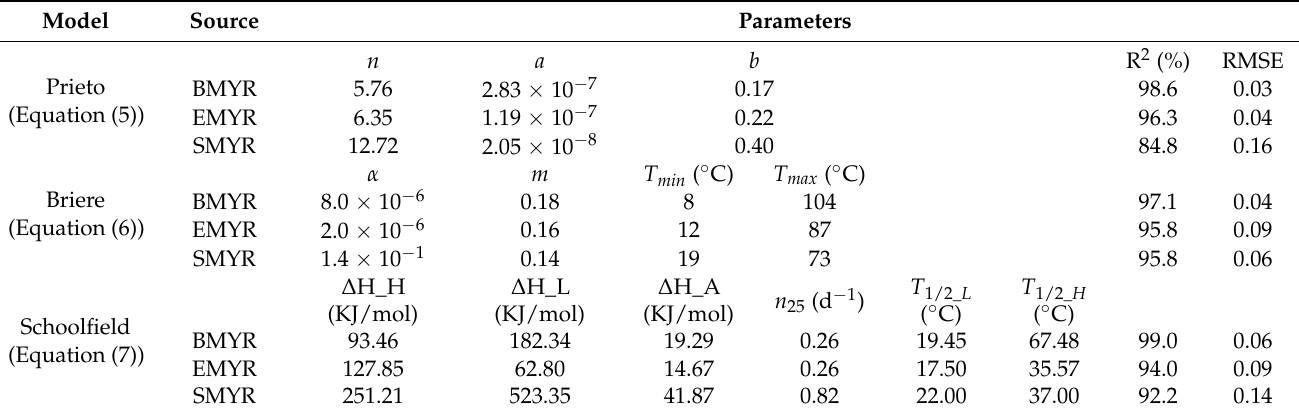
Table 3. Adjustment of temperature-dependent models to myrosinase kinetics.